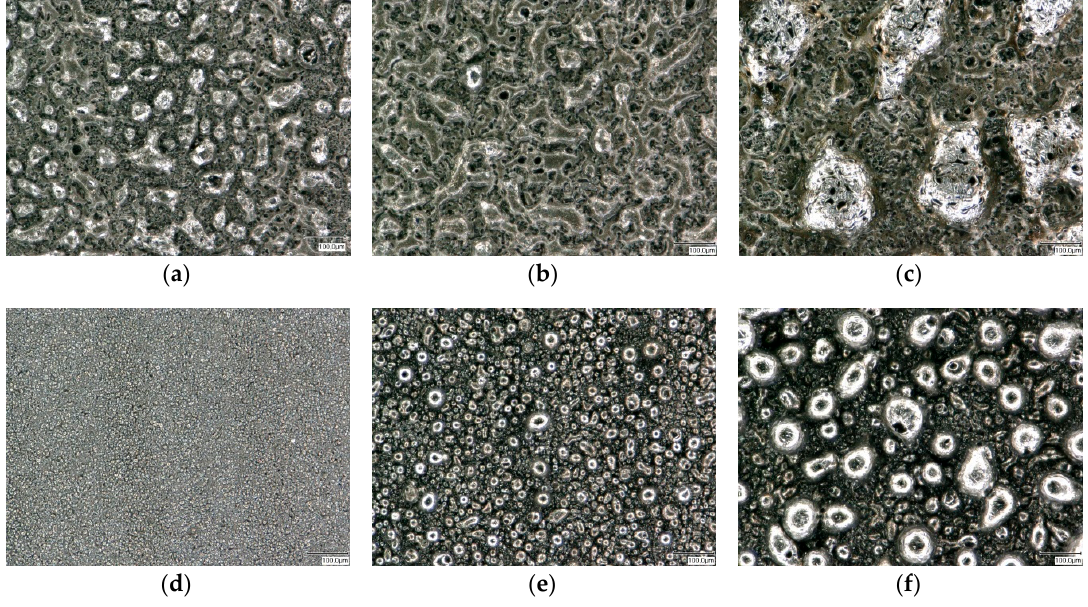
Figure 8. Top view microscopy images of p-type material treated with ( a ) E sq. = 0.048 J/mm²; ( b ) E sq. = 0.080 J/mm²; ( c ) E sq. = 0.160 J/mm²; and n-type material treated with ( d ) E sq. = 0.053 J/mm²; ( e ) E sq. = 0.107 J/mm²; ( f ) E sq. = 0.200 J/mm².